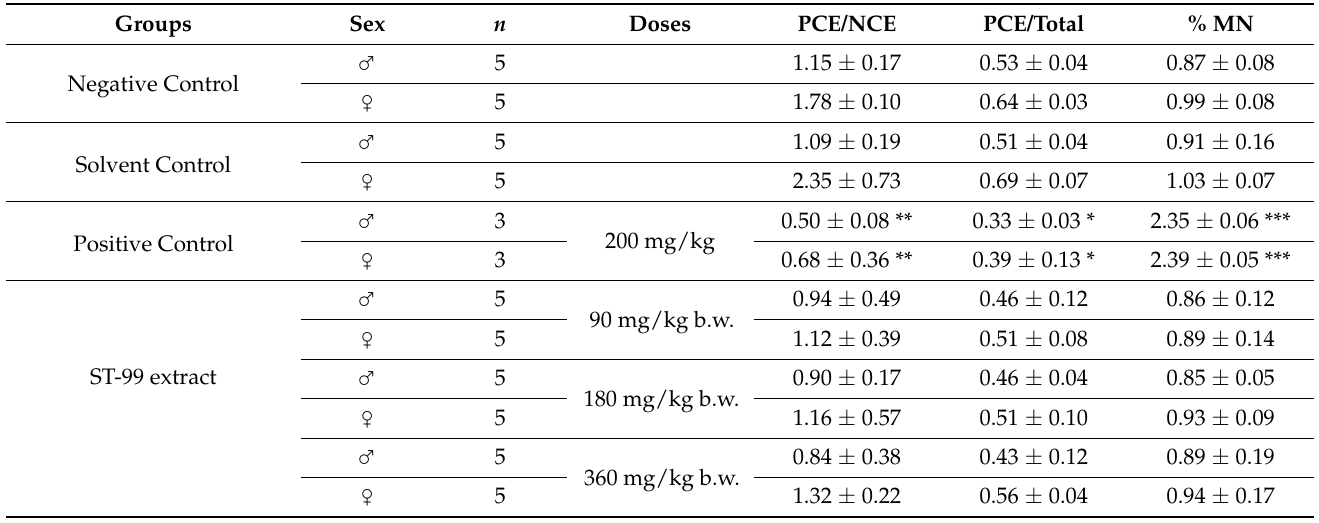
Table 1. Micronucleus assay results in male ( erythrocytes (PCE) among total erythrocytes (normochromatic erythrocytes (NCE) + PCE), ratio PCE among NCE, and the micronuclei induction expressed as % micronucleus